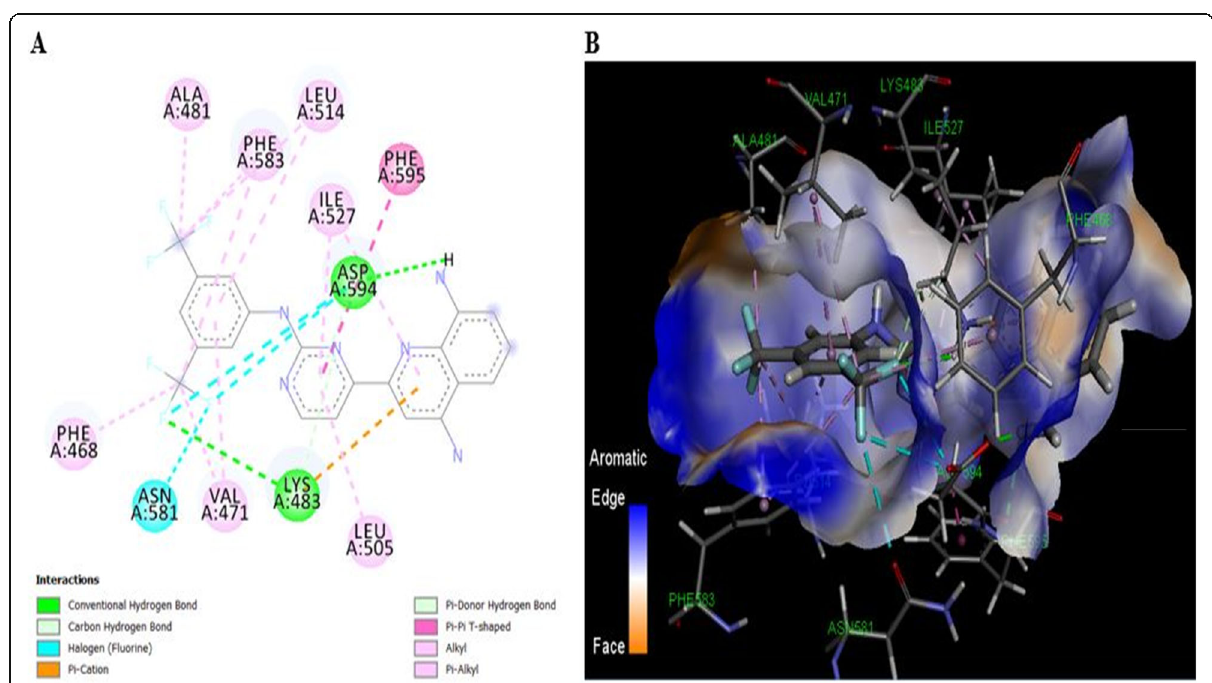
Fig. 4 a 2D diagram for the interaction of compound 10 with V600E-BRAF. b 3D diagram of compound 10 in the binding site of V600E-BRAF